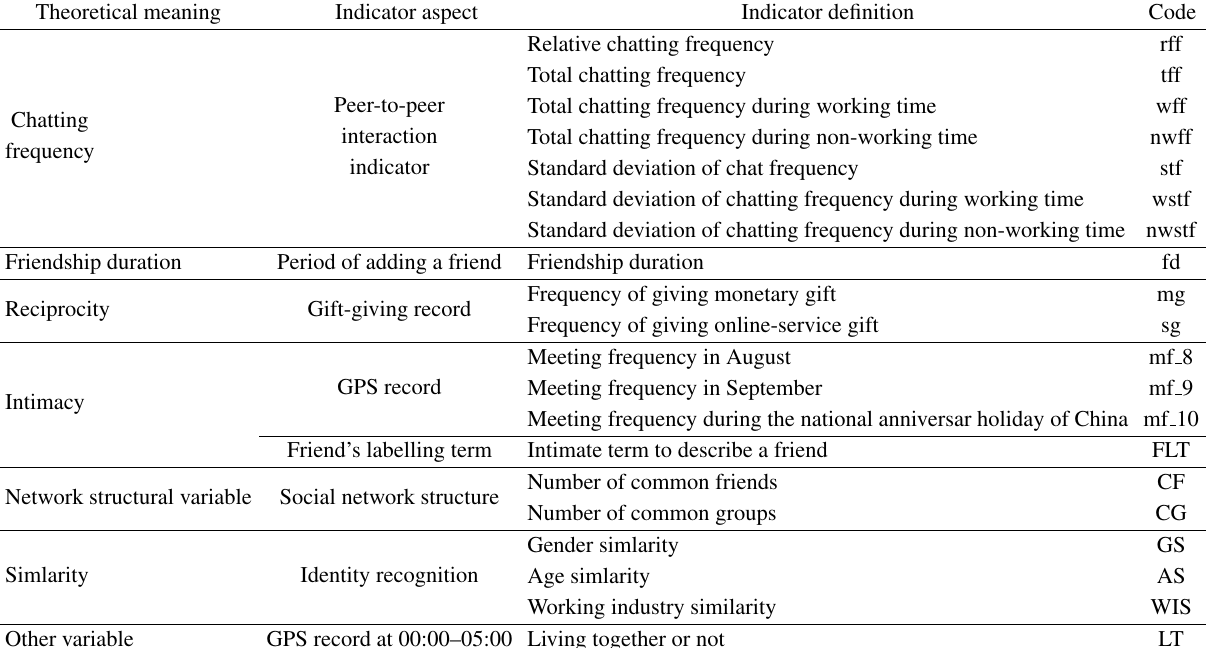
Table 1 Explanations and definition of indicators.